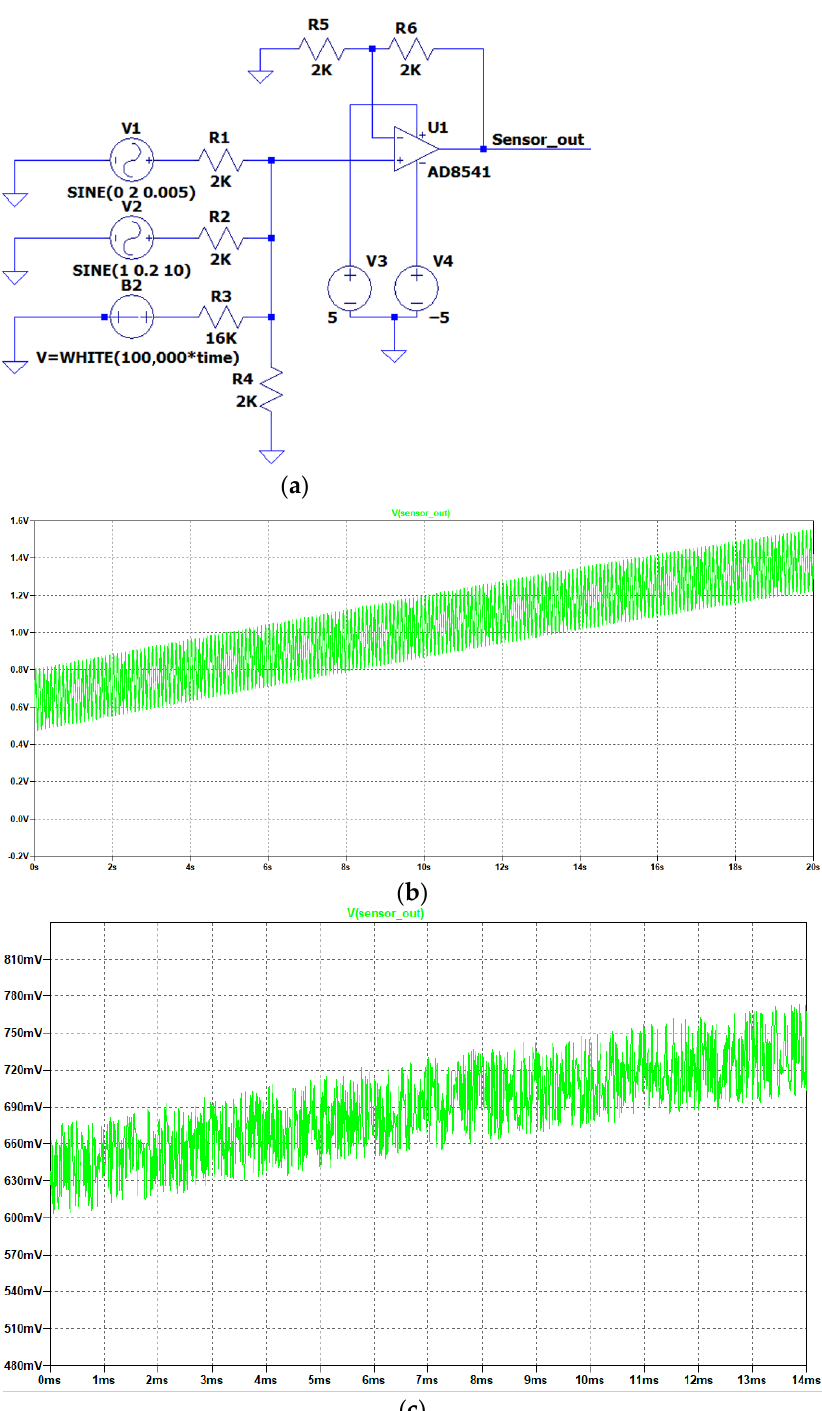
Figure 5. Test signal generation: ( a ) circuit for the test signal generation, ( b , c ) generated output signal at different display scales (Sensor_out).